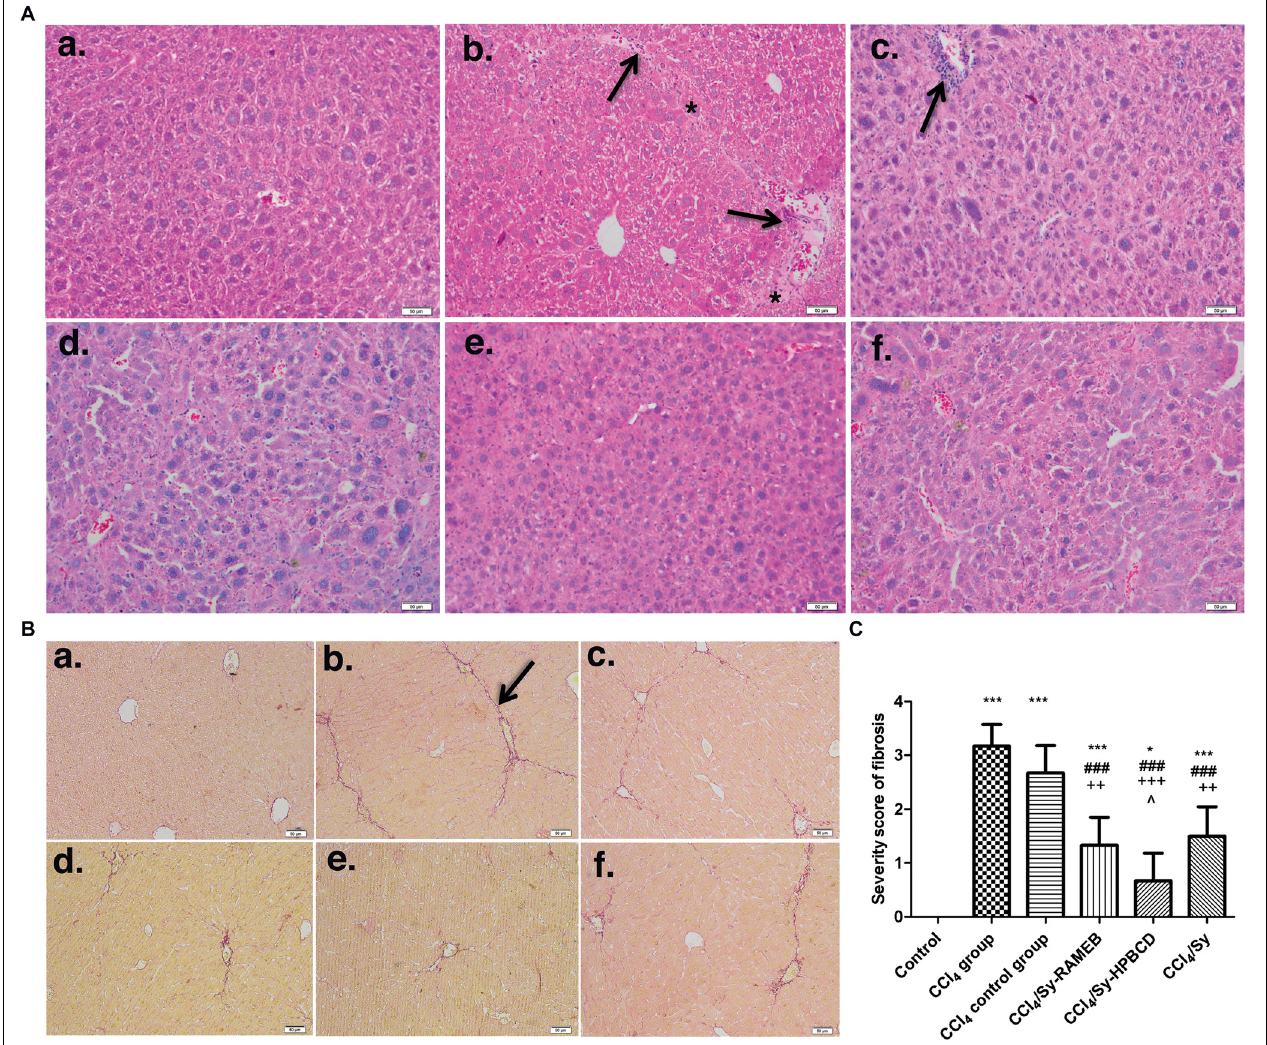
FIGURE 4 | Effect induced by Sy-HPBCD and Sy-RAMEB complexes on the histological changes in liver of CCl 4 -treated mice. (A) H&E. (a) Control group: normal lobular architecture and cell structure; (b) CCl 4 -treated group: extensive hepatocellular damage with the presence of inflammatory cell infiltration, steatosis and necrosis, pseudo-lobular formation with collagen deposition; (c) CCl 4 -control group: the recovery was still weak and aspect almost similar to CCl 4 -treated group; (d) CCl 4 and Sy-RAMEB co-treated group: mild inflammation, minimal hepatocellular necrosis and less extended fibrotic septa; (e) CCl 4 and Sy-HPBCD co-treated group: histological aspect closest to the control with minimal inflammatory cells; (f) CCl 4 and free Sy co-treated group: minimal fibrotic changes are present. ∗ Fibrotic septa and collagen deposition; arrow – inflammatory cell infiltration; scale bar – 50 µ m. (B) Fouchet van Gieson trichrome. (a) Control group: no significant collagen deposition; (b)